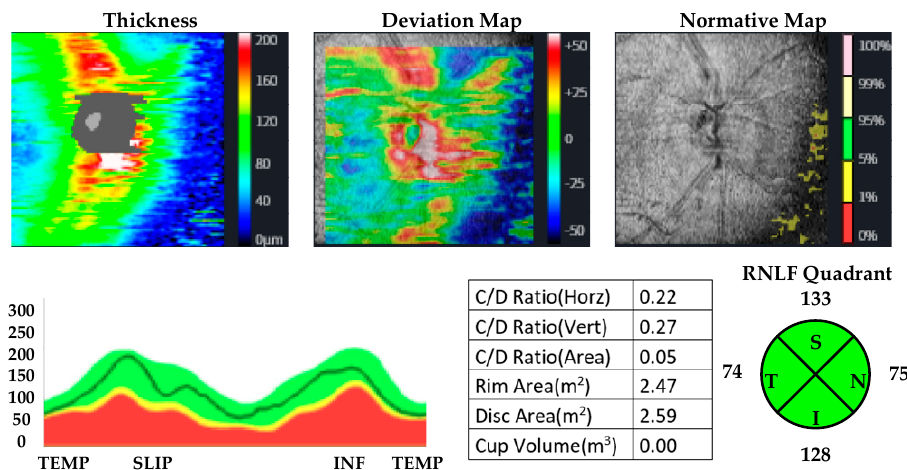
Figure 2. OCT analysis of the RNLF in a patient with methamphetamine use disorder.